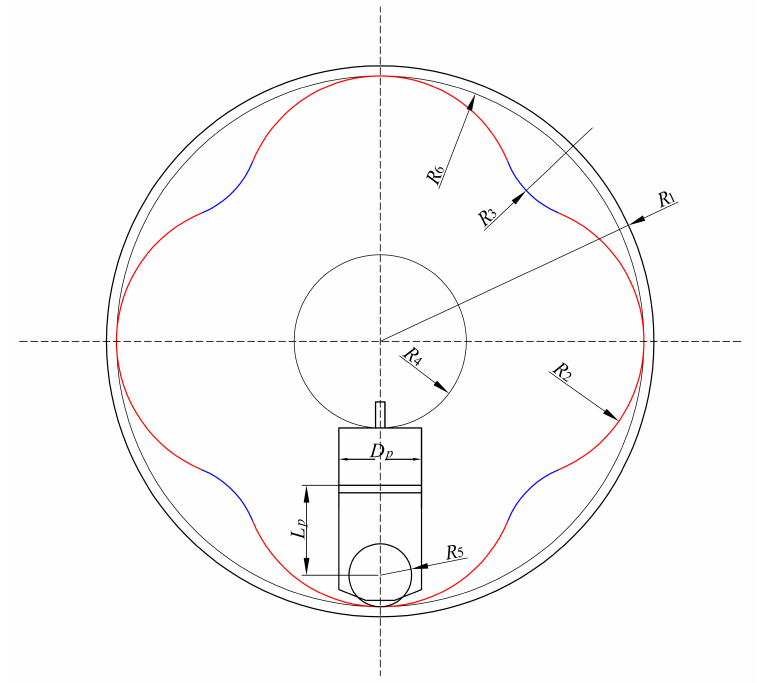
Figure 3. Key dimensional